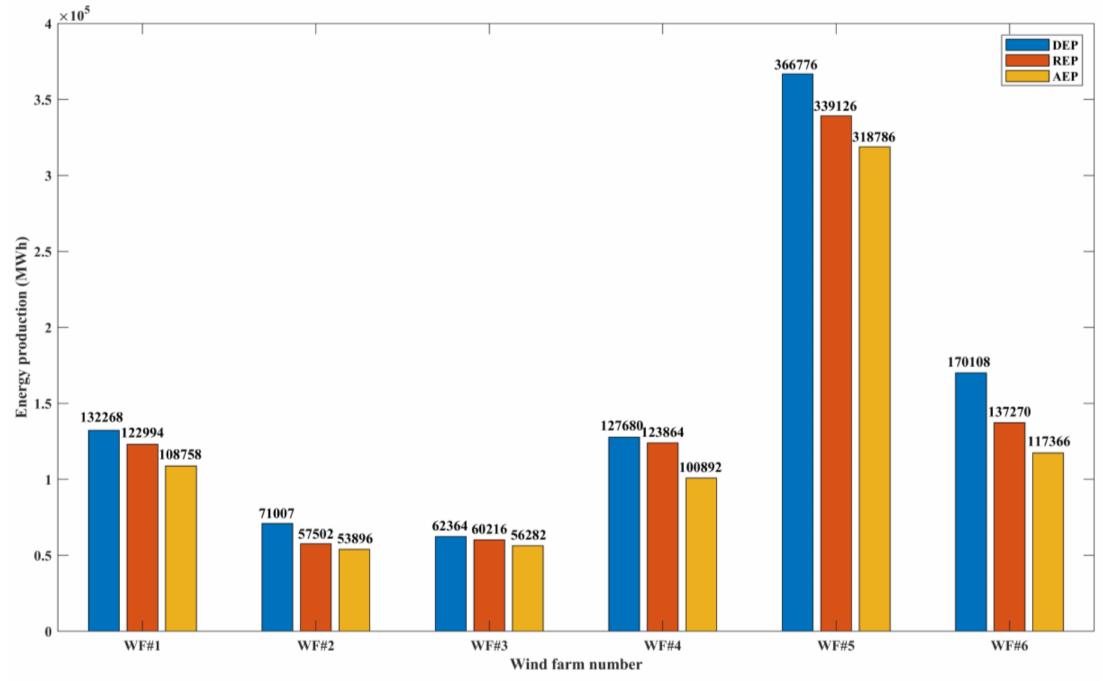
Figure 6. The calculation results of DEP/REP/AEP of wind